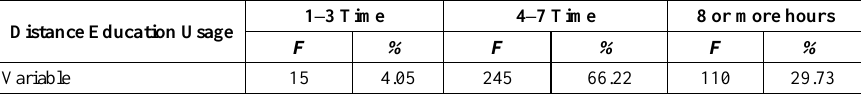
Table 3. Distance education usage process time of academicians